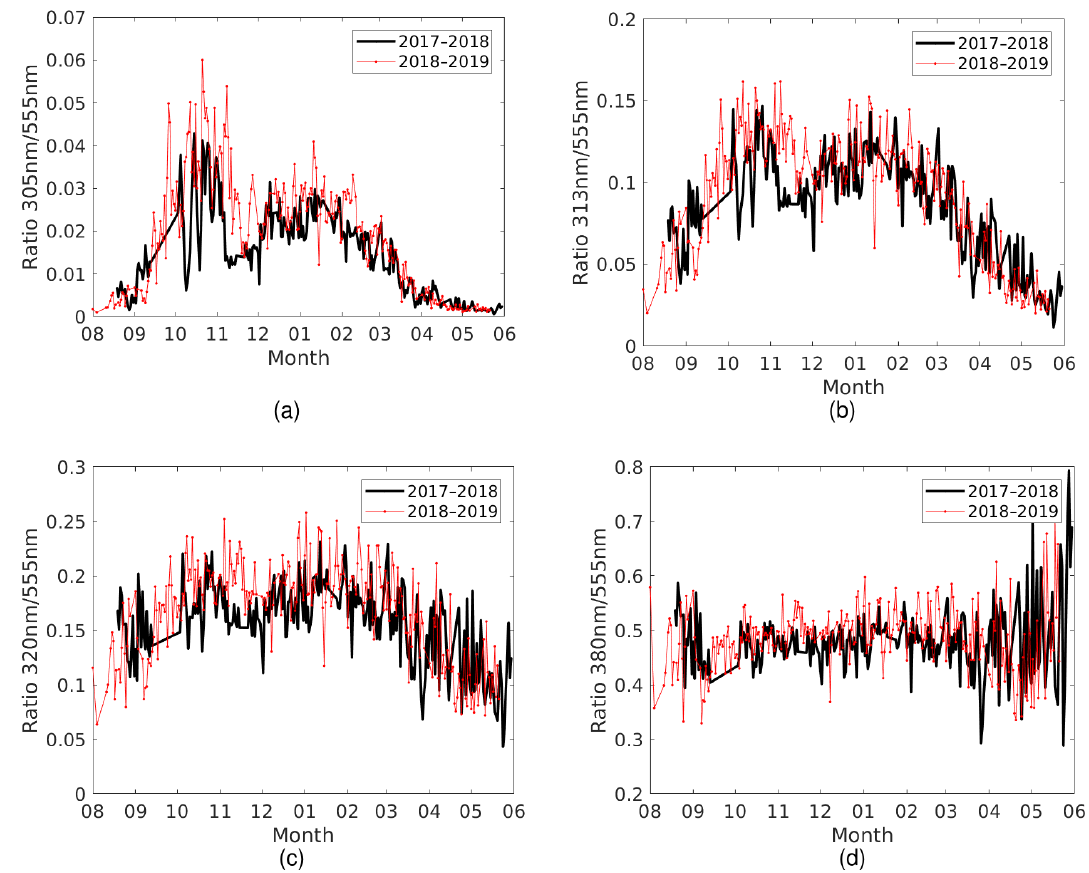
Figure 8. Ratio of daily maximum UV irradiances and VIS irradiances for the months August–May during the periods 2017–2018 and 2018–2019. UV irradiances at (a) 305nm, (b) 313nm, (c) 320nm and (d)